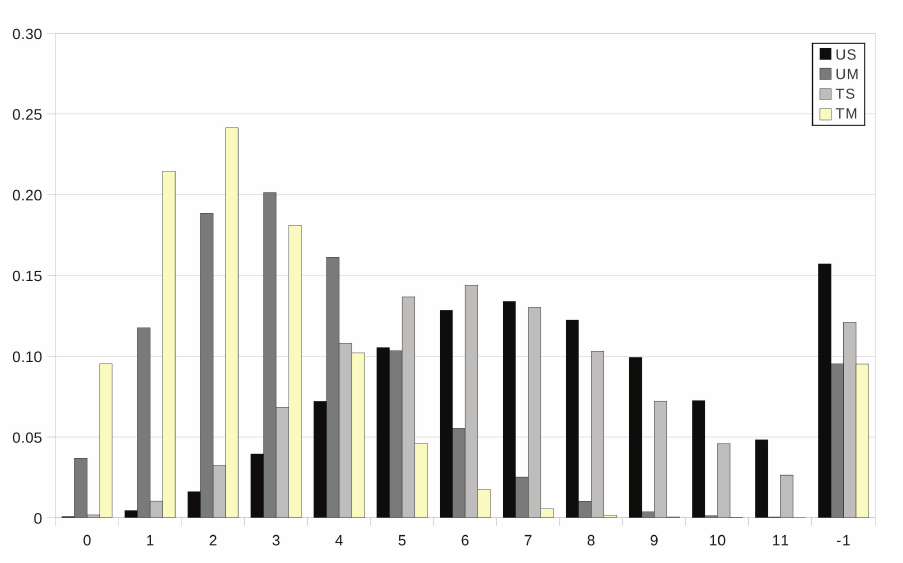
Figure 5. The mass function of the parasite burden M ( τ ) at age τ = 1 year. Scenario US and grazing strategies UM, TS and TM (from left to right) with the anthelmintic ivermectin as the intervention prescribed at age t 0 =